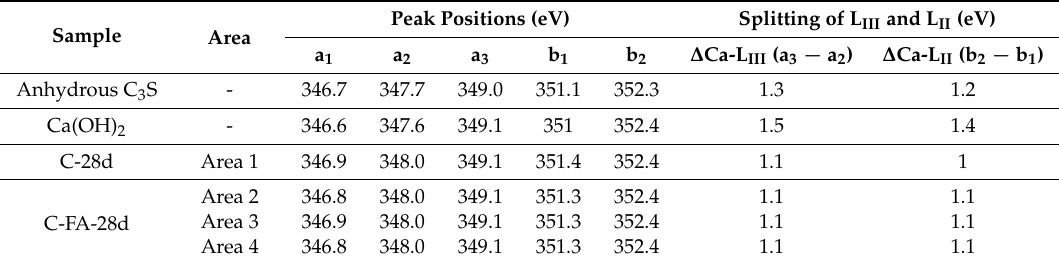
Figure 5. The scanning transmission X-ray microscopy (STXM) results of C-28d. ( a ) Single image of C-28d taken at 349 eV; ( b ) Ca image contrast map of C-28d; ( c ) single image of C-FA-28d taken at 340 eV; ( d ) Ca image contrast map of C-FA-28d; and ( e ) Ca L III,II edge near-edge X-ray fine structure (NEXAFS) spectra of anhydrous C 3 S, C-28d, and C-FA-28d extracted from the ROIs specified in ( b , d ). Table 2. Ca L III,II edge peak positions and splitting energy of anhydrous C 3 S, Ca(OH) 2 , and regions of interest (ROIs) in C-28d and C-FA-28d.